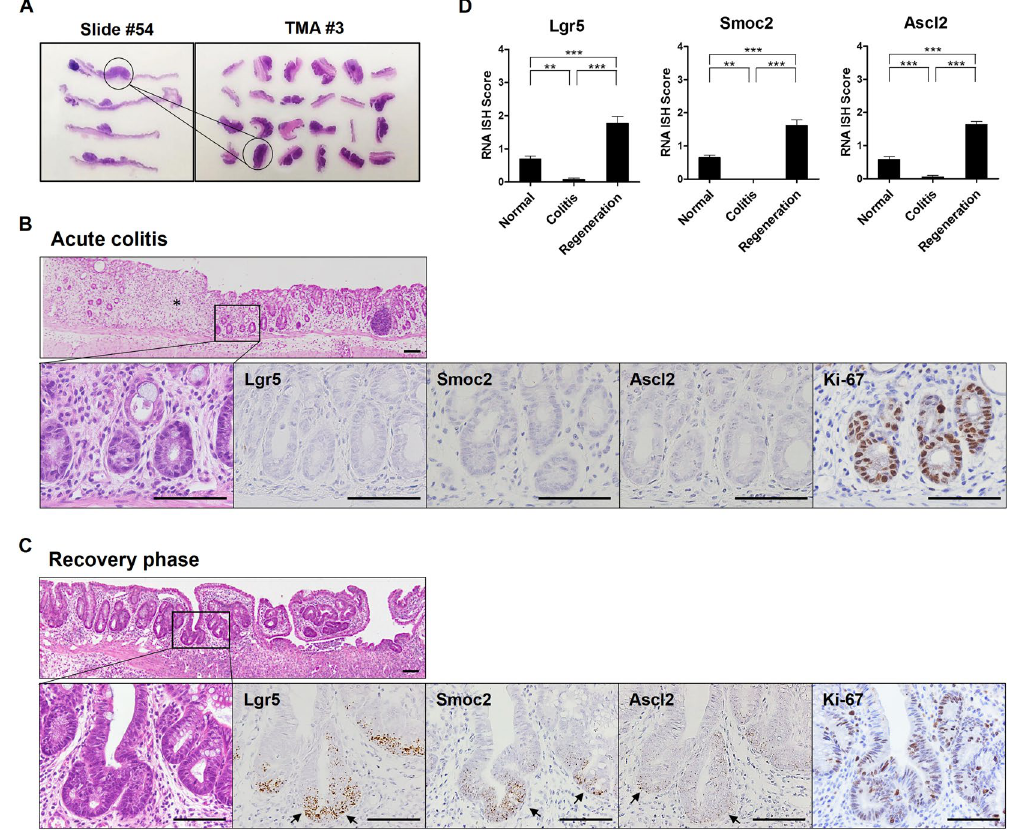
Figure 3. Crypt base columnar (CBC) stem cell marker expression during regeneration after acute colitis. ( A ) Construction of three tissue microarrays from 56 hematoxylin and eosin-stained slides, containing 72 representative cores. ( B ) Representative images of acute colitis after the first DSS treatment (day 15) with reduced expression of CBC stem cell markers. RNA in situ hybridization (ISH) for Lgr5, Smoc2, and Ascl2 and immunohistochemistry for Ki-67. Asterisk indicates crypt loss in the lamina propria. Scale bar: 50 μ m. ( C ) Representative images of regenerative glands (day 26) with increased expression of CBC stem cell markers at the base of the crypts. Arrows indicate stem cell marker-expressing cells. ( D ) Expression of CBC stem cell markers in normal mucosa, acute colitis, and during regeneration. RNA ISH score was assessed in 38 to 67 colon crypts. Data represent the means ± SEM. (N: normal, n = 2; C: colitis, n = 3; R: regeneration, n = 4). SEM, standard error of the mean. ** P < 0.01; *** P <